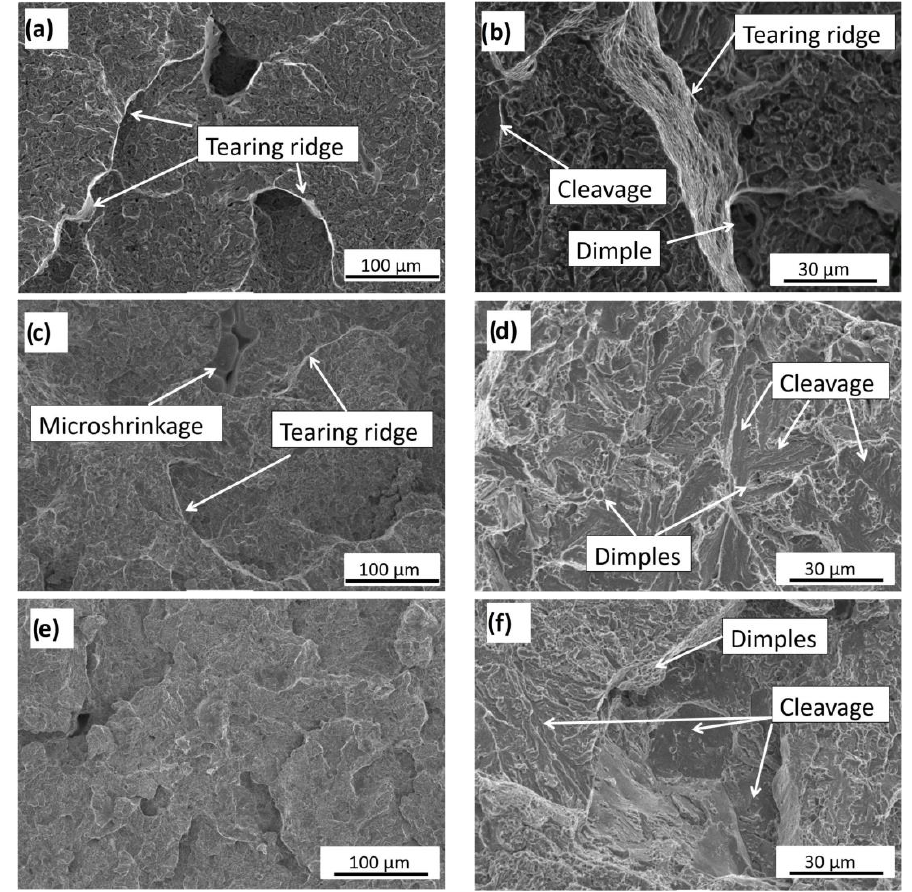
Figure 17. SEM micrographs showing fracture surface of tensile samples: ( a , b ) transformed at 280 °C,( c , d ) transformed at 330°C, and ( e , f ) transformed at 380 °C.